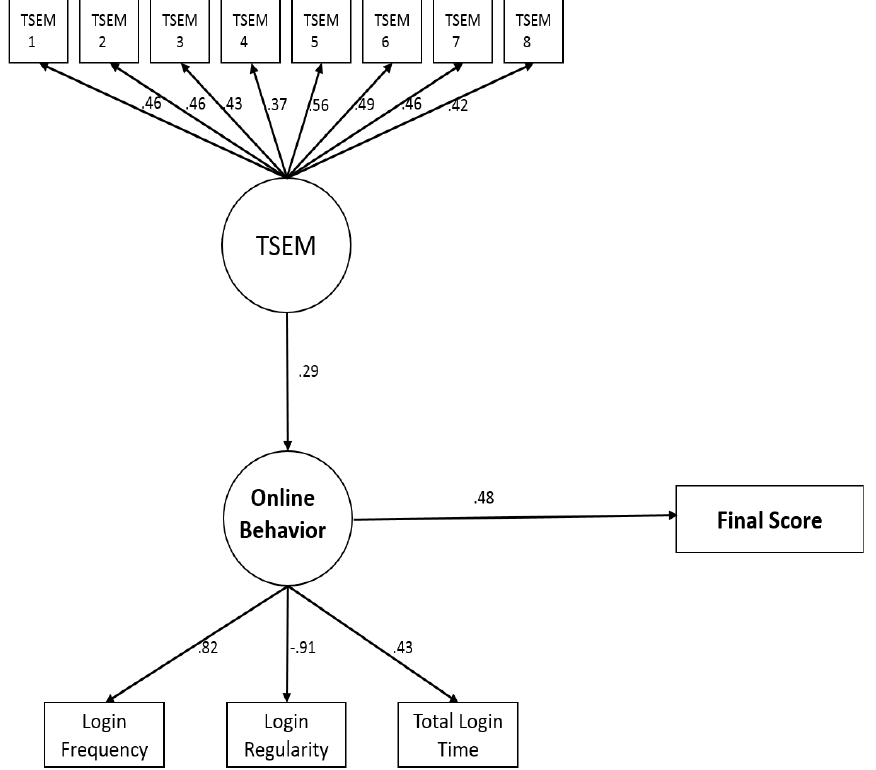
Figure 3. Estimated coefficients for the modified measurement model